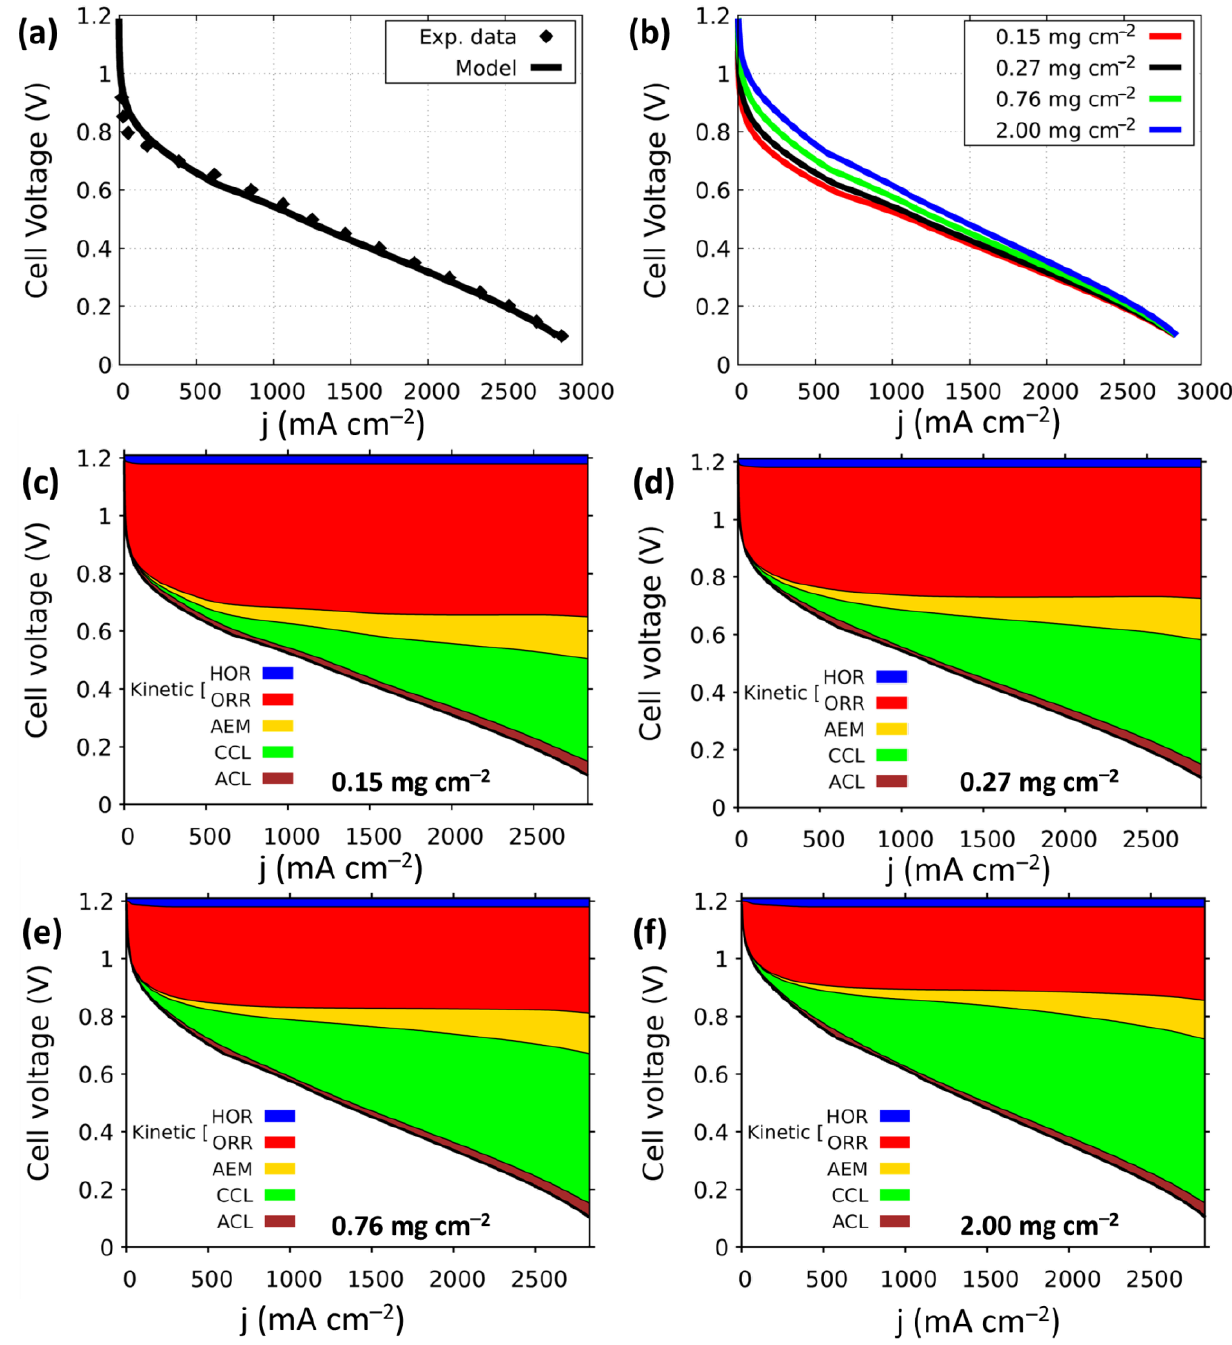
Figure 7. AEMFC modeling results: A comparison of the calculated (solid lines) and measured (dots) initial performance of the AEMFC operated with a CoO x -Fe 3 O 4 /N-rGO cathode catalyst with 0.27 mg cm − 2 loading ( a ). Simulated initial performance of AEMFCs operated with different cathode catalyst loadings ( b ). Calculated overpotential distribution of AEMFC cell performance for different cathode catalyst loadings ( c – f ).